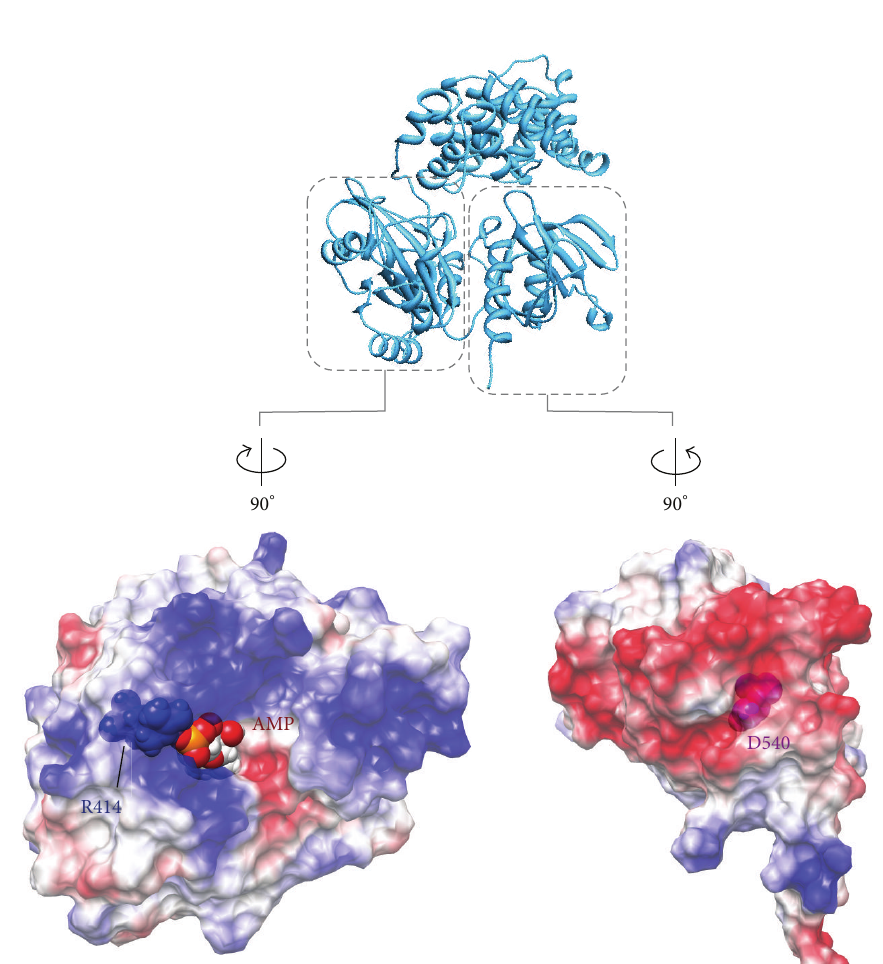
Figure 12: The electrostatic distributions on the interacting surfaces of AdD (bottom, left) and OBD (bottom, right), in which one of the ionic interaction pairs (Arg414 and Asp540) is highlighted as sphere